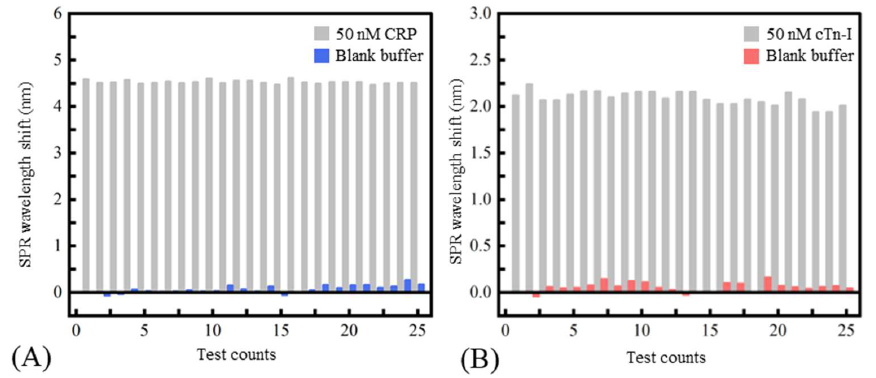
Figure 6. The repeatability of the biosensor: ( A ) the sensor modified with the CRP aptamer; ( B ) the sensor modified with the cTn-I aptamer.